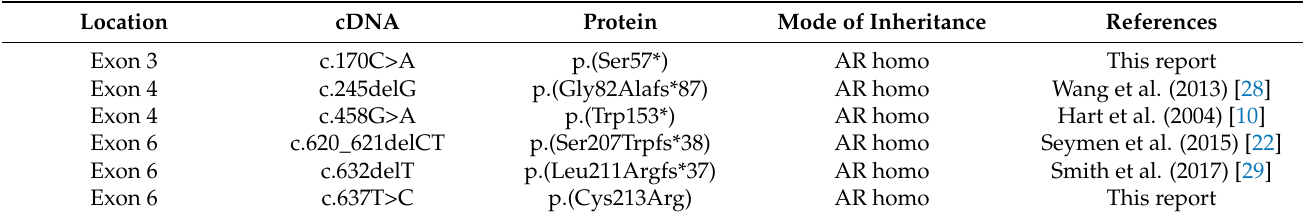
Table 1. Disease-causing mutations in KLK4